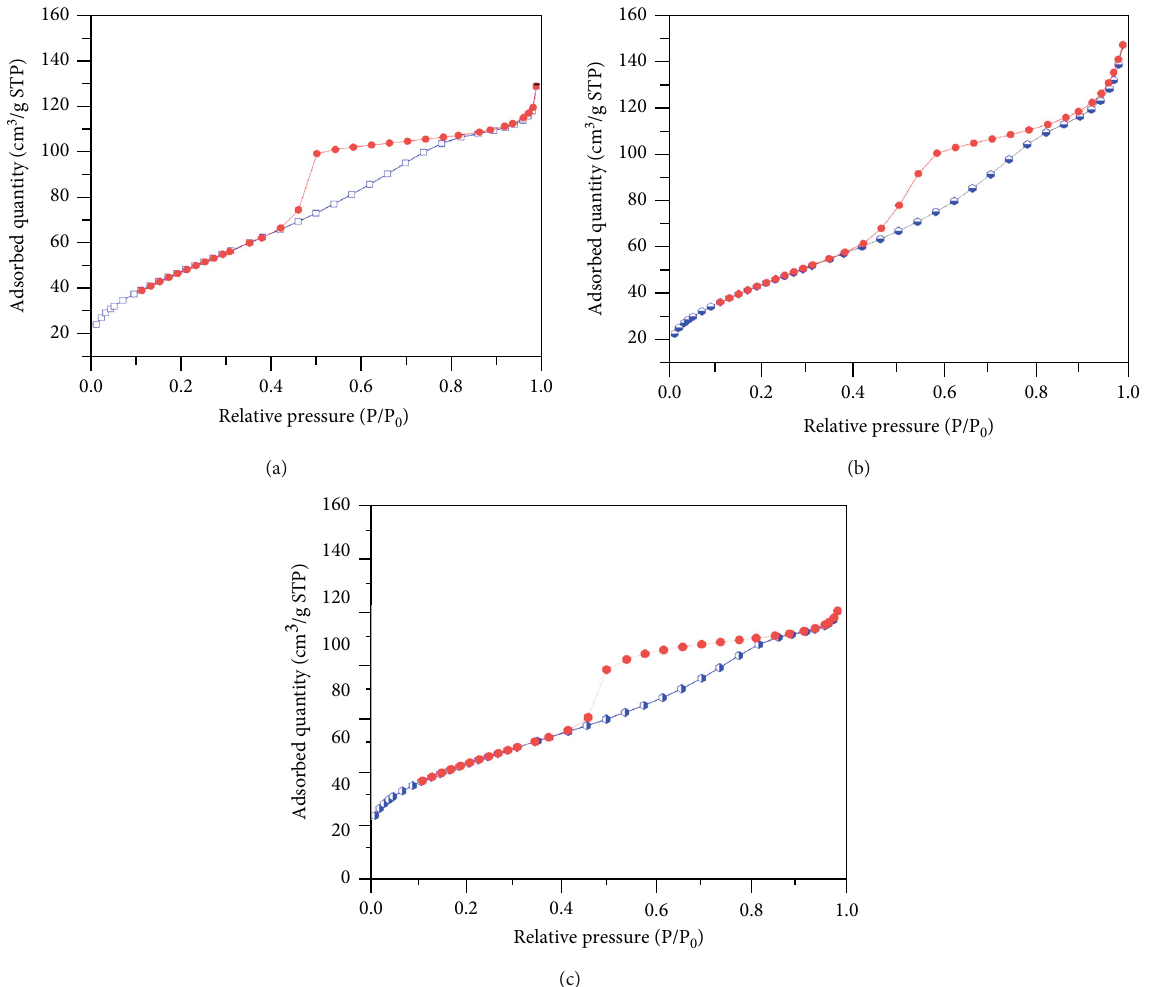
Figure 4: Nitrogen adsorption-desorption isotherms of representative samples: (a) TiO 2.5%Fe